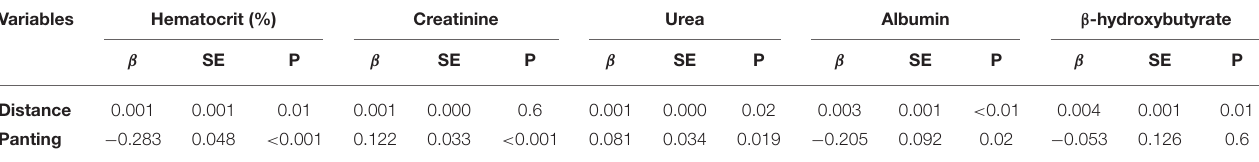
TABLE 6 | Relationships between physiological welfare indicators variables in blood from non-ambulatory pigs and transport distance and panting * .